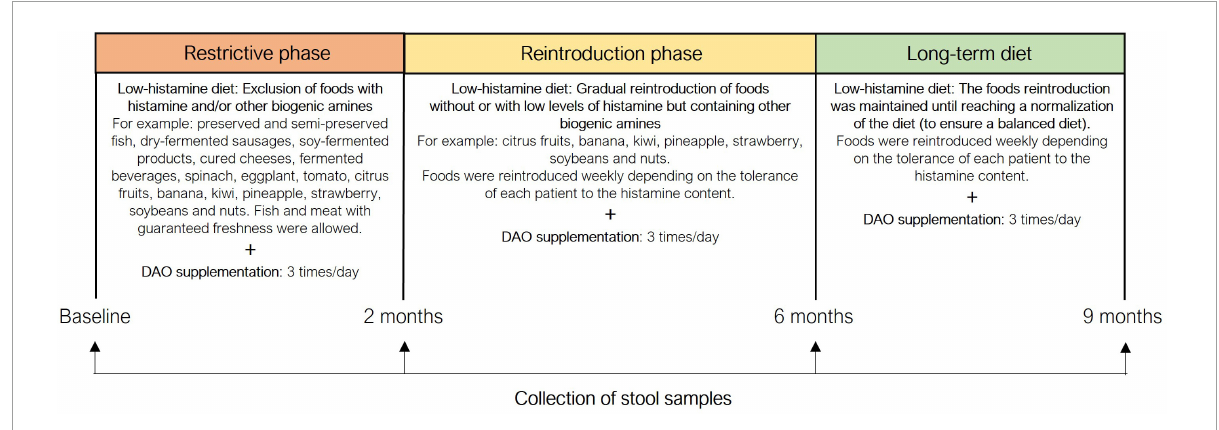
FIGURE1 The different phases of the dietary treatment and stool sample collection during the 9-month study.